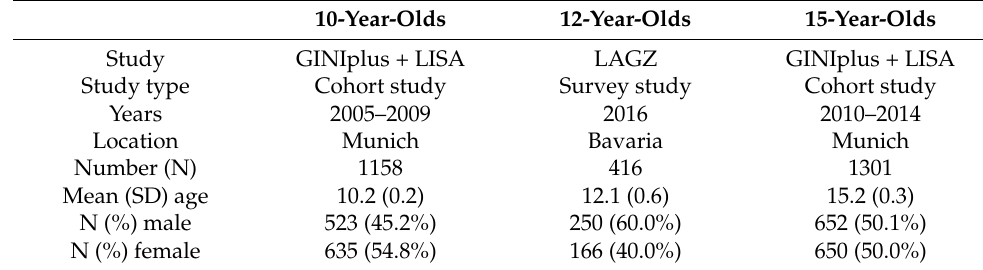
Table 1. Characteristics of investigated individuals in the three study populations.